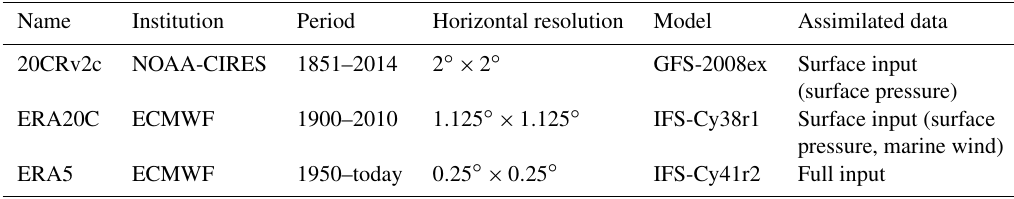
Figure 1. (a) Map of western Europe with the northern French Alps (red) and the domain considered for the 500hPa geopotential height (blue). (b) Altitudinal map (in m) of the Isère River and the Drac River catchments at Grenoble, with the main cities and rivers. The dotted purple line represents the climatological border of Auer et al. (2007). Coordinate projection is according to the Lambert II extended system. Table 1. Main properties of the reanalyses